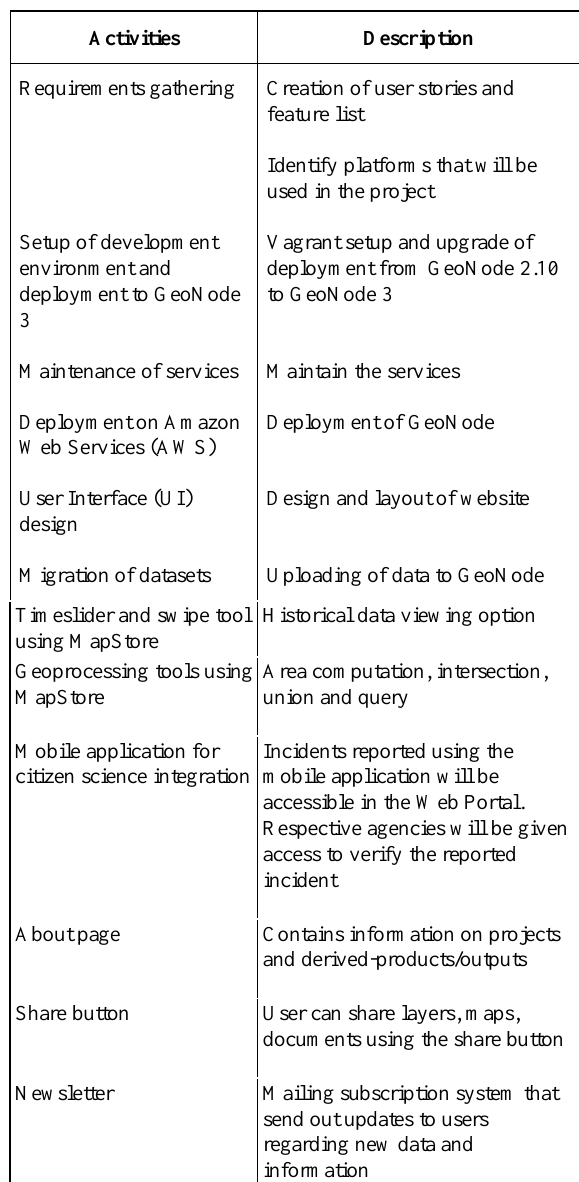
Table 2 . MapABLE Web GIS development